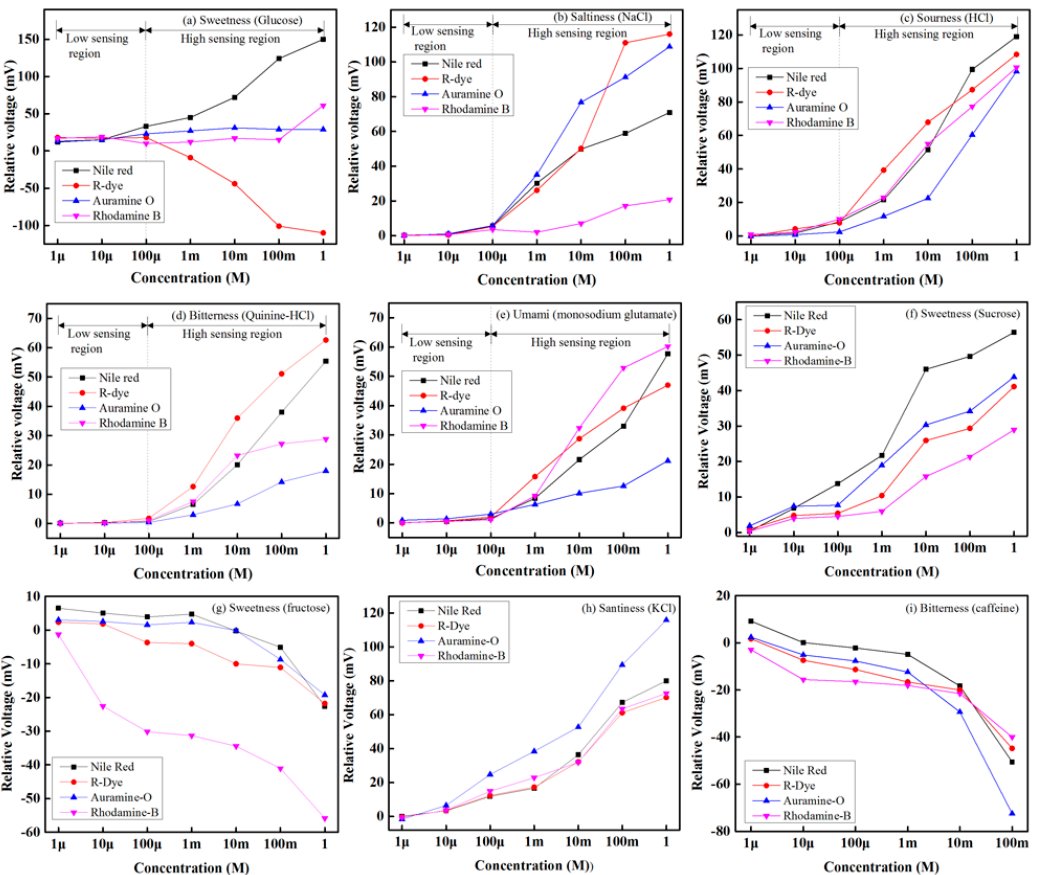
Figure 11. Sensing response of the designed IDC sensing elements for various tastes and concentrations: ( a ) sweetness (glucose); ( b ) saltiness (NaCl); ( c ) sourness (HCl); ( d ) bitterness (quinine-HCl), ( e ) umami (monosodium glutamate); ( f ) sweetness (sucrose), ( g ) sweetness (fructose); ( h ) saltiness (KCl); and ( i ) bitterness (caffeine).